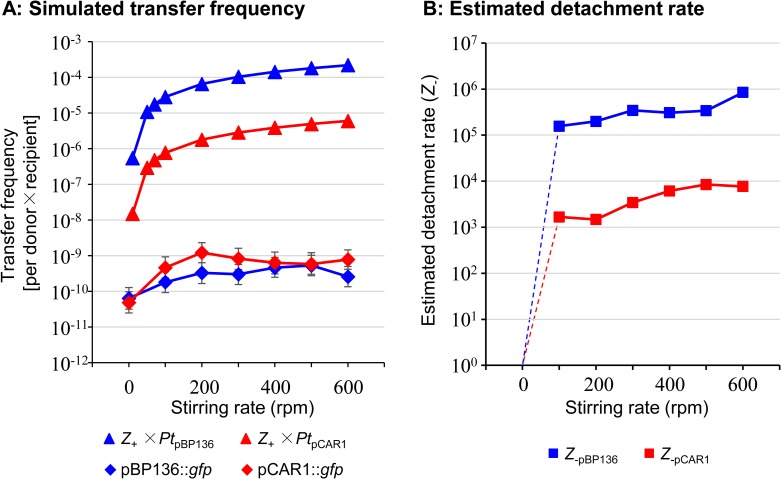
The simulated transfer frequency and detachment rates of plasmids.(A) The simulated and experimental transfer frequency of pBP136::gfp and pCAR1::gfp in different stirring rates at cell density of 106 CFU/mL. Note that the simulated transfer frequency are shown from 10 to 600 rpm. The experimental data of the number of transconjugants shown in Fig 3 are also shown in the graph for comparison, blue (pBP136::gfp) and red (pCAR1::gfp). (B) The estimated detachment rates (Z-) in different stirring rates. Blue; Z-pBP136 and red; Z-pCAR1. The detachment rate at 0 rpm could not be calculated but be closer to 0 (dash lines). The raw data of this figure are in S4 Table.